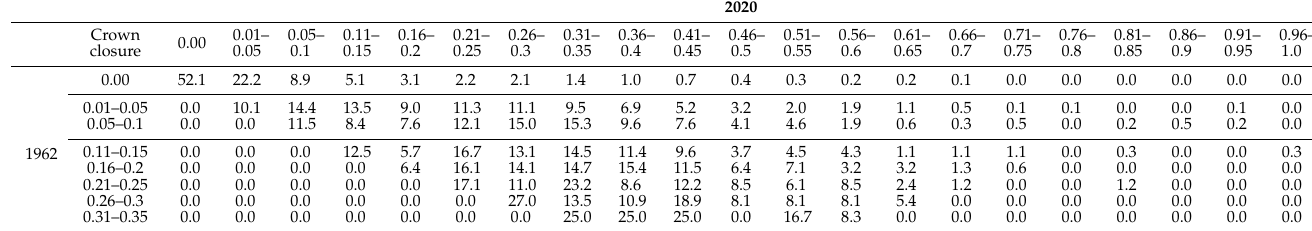
Table 2. Matrix of transition (in %) of plots with different crown closures in 1962 into plots with different crown closures in 2020 on southern and eastern slopes of a hill with a height mark of 312 m a.s.l., close to Mt. Chernaya (Polar Urals).